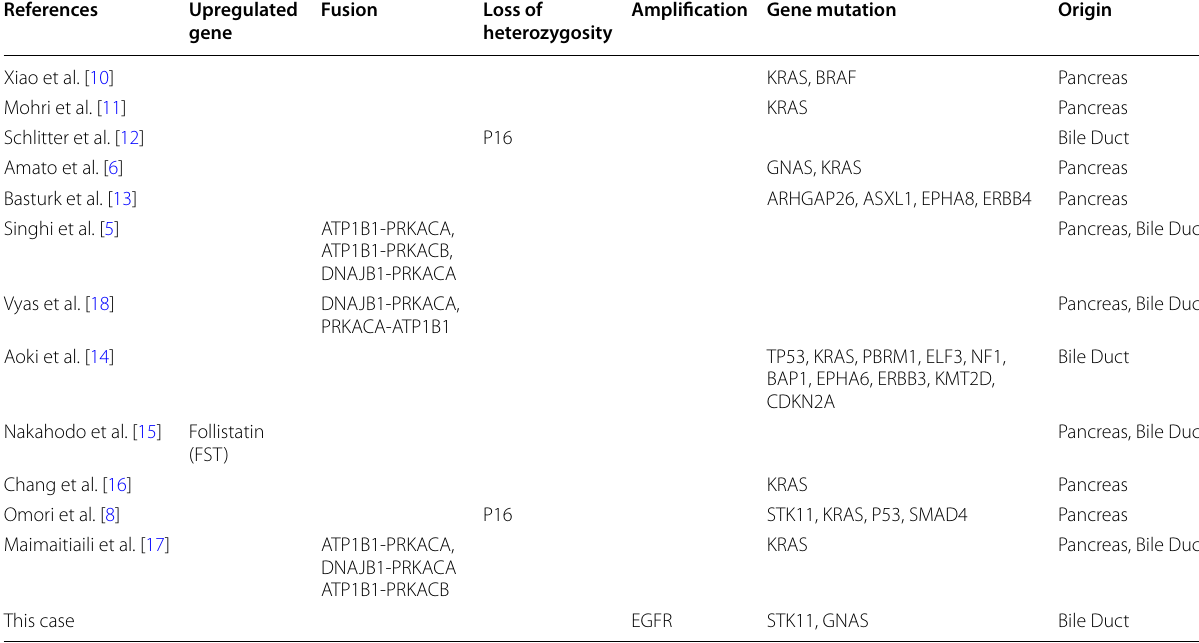
Table 2 Review of reported molecular alterations of